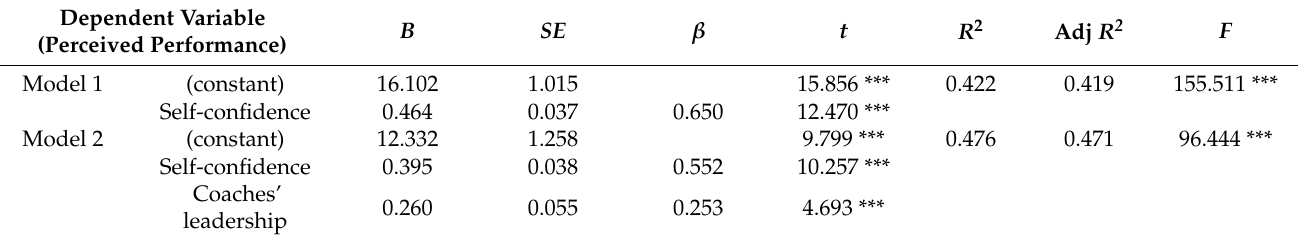
Table 6. Multiple regression analysis ( n = 215).